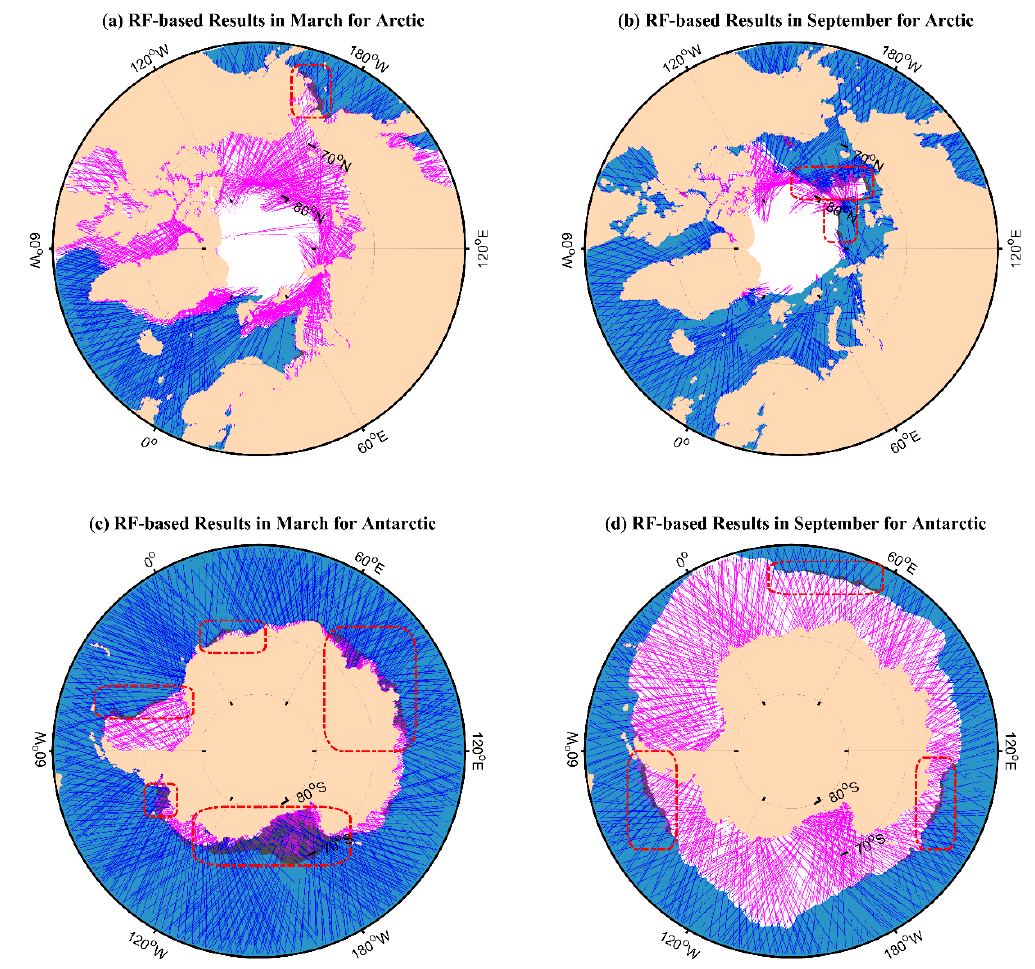
Figure 10. RF-based GNSS-R sea ice monitoring results in March and September 2018 are mapped with the OSISAF SIE for the Arctic and Antarctic regions: ( a ) March 2018 for the Arctic region. ( b ) September 2018 for the Arctic region. ( c ) March 2018 for the Antarctic region. ( d ) September 2018 for the Antarctic region. The dark gray (partly marked by a rounded rectangle with a red dotted line) and white edge represent the maximum and minimum ice extent in each month. The magenta points represent the ground tracks of GNSS-R sea ice, while the blue points stand for those of GNSS-R sea water.